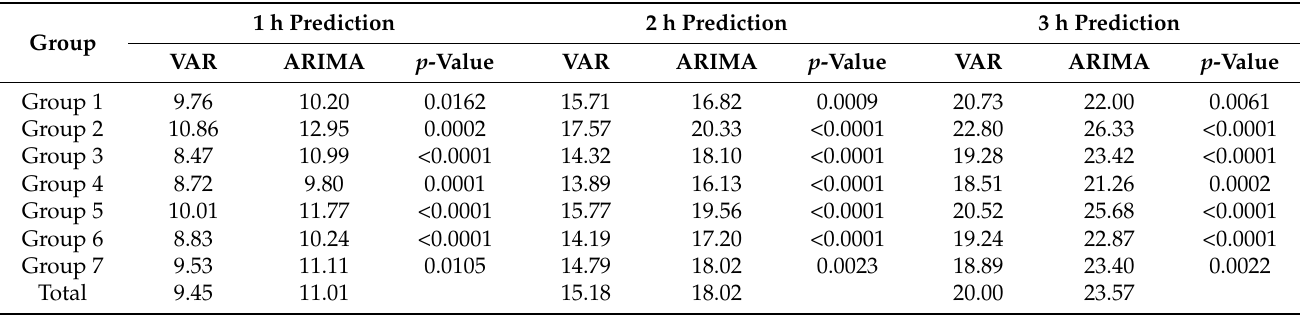
Table 6. Comparison of the VAR and ARIMA models based on nRMSE for 1–3 h advance power forecasting.